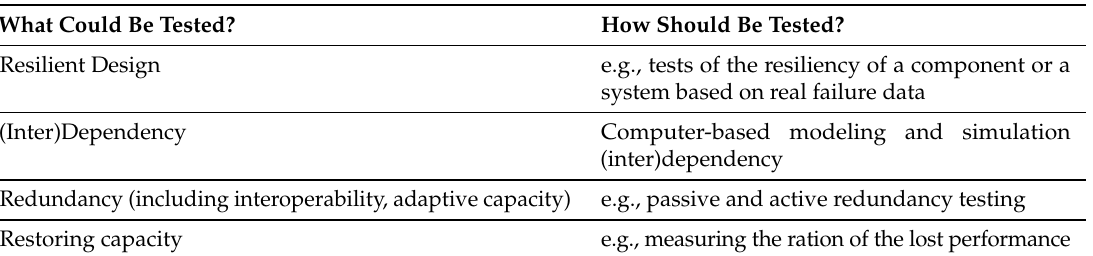
Table 1. Information extracted from the table in